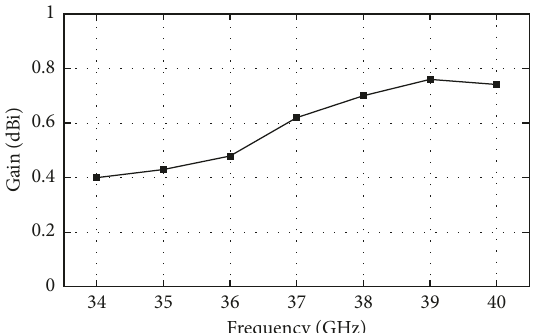
Figure 9: Measured peak gain values of the fabricated OCA at different